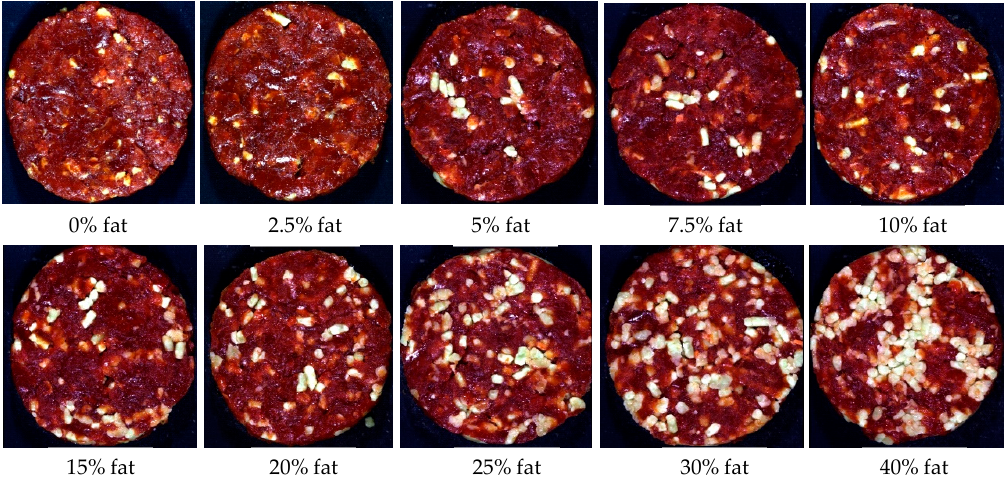
Figure 1. Digital images of the various fat percentages for Patty 1 (ground burger/ground patty).